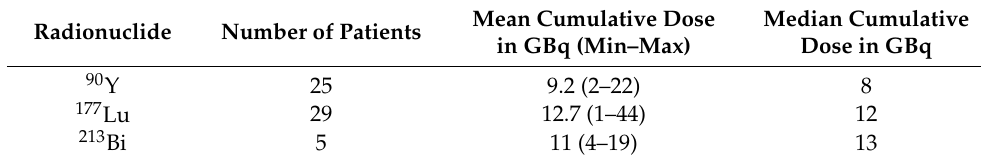
Table 3. Details of PRRT for the 32 patients pretreated.